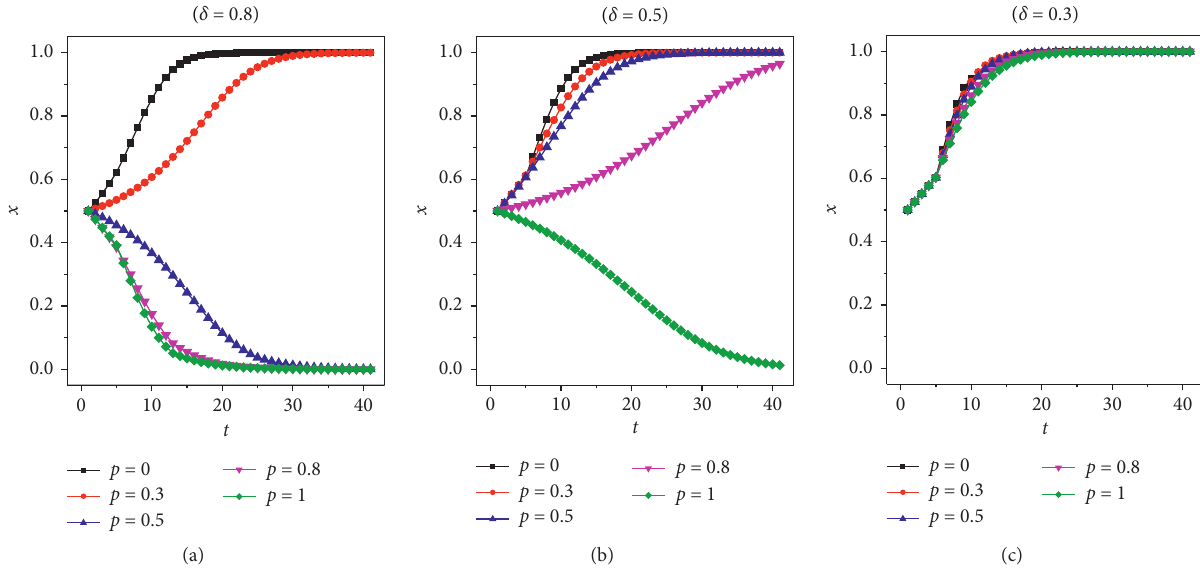
Figure 8: The proportion of innovation-leading firms in the group for different decision-making attitude p on three levels of the innovation risk δ based on the improved game